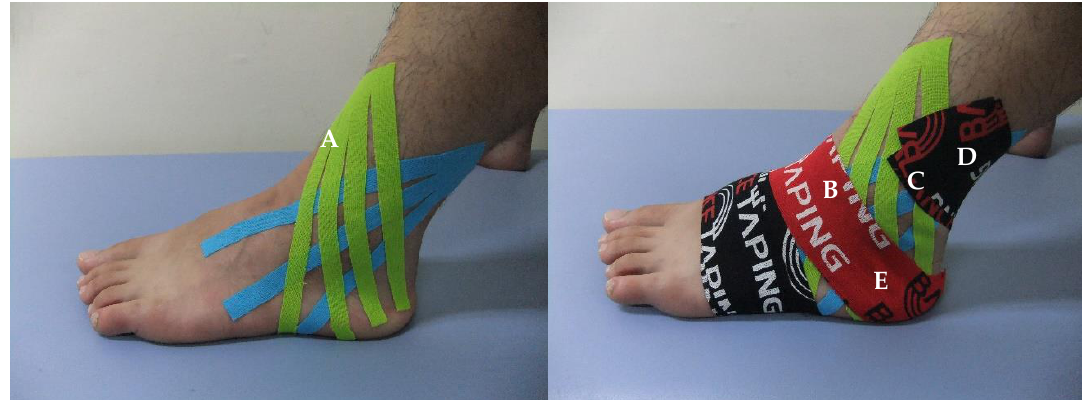
Figure 2. Ankle eversion taping using kinesiology tape for acute ankle inversion sprain (( A ), fan-shaped strips of kinesiology tapes were applied to the lateral malleolus and dorsum area; ( B ), taping was applied from the talus to the calcaneus on both sides; ( C ), taping was applied to the medial calcaneus under the subtalar joint starting at 5 cm above the lateral malleolus and facing the medial side of the instep; ( D ), taping was applied in the same manner to overlap approximately 80% of the tape applied in the previous step; ( E ) , taping was applied over that from the first step).